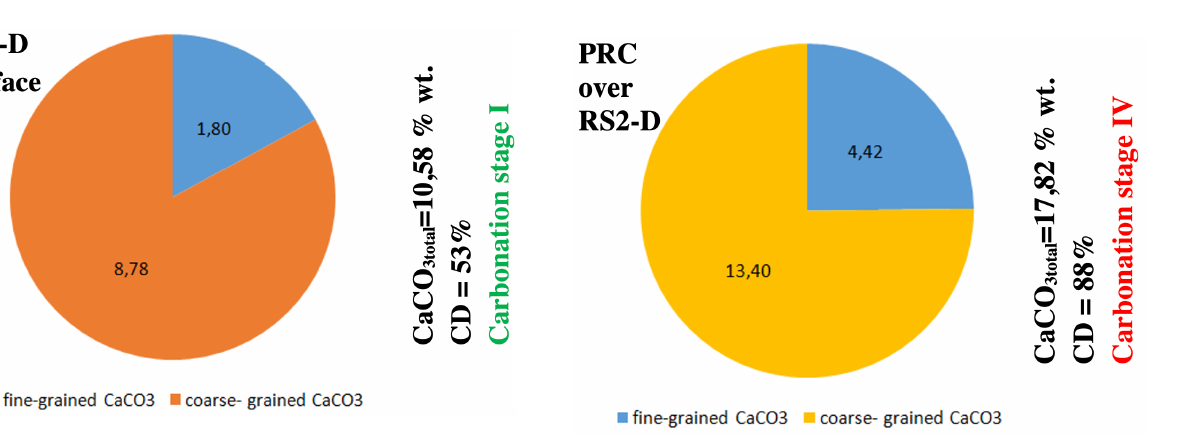
Figure 12. The amount of CaCO 3 (% wt.) in the surface layer of the protected concrete sample RS2-D by PRC.